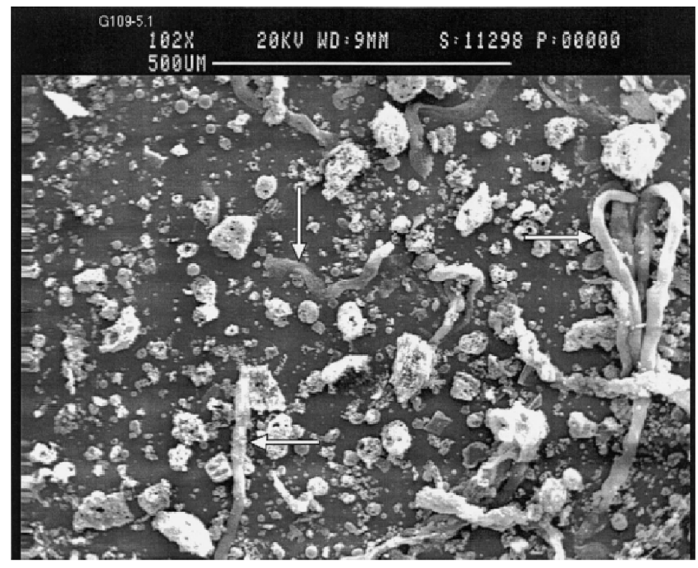
Figure 2. SEM micrograph of fly ash carbon rich particles adapted from Veranth et al. [41].